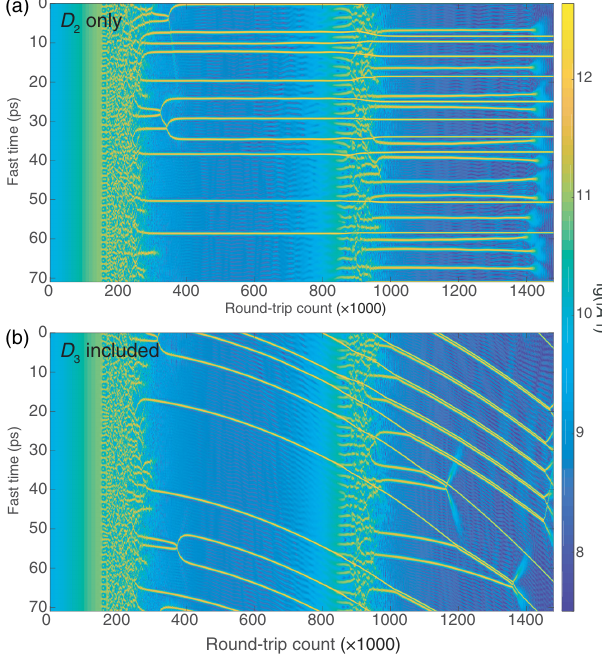
FIG. 12. Experimental realization of single-cavity-resonance excitation with dual pumping. (a) Two experimental configura- tions we use to pump two dissimilar soliton microcombs from the same cavity resonance. (b) The microcomb spectrum generated with the dual-laser configuration. The constituent soliton pattern is illustrated in the inset. (c) The microcomb spectrum generated with the one-laser-with-EOM